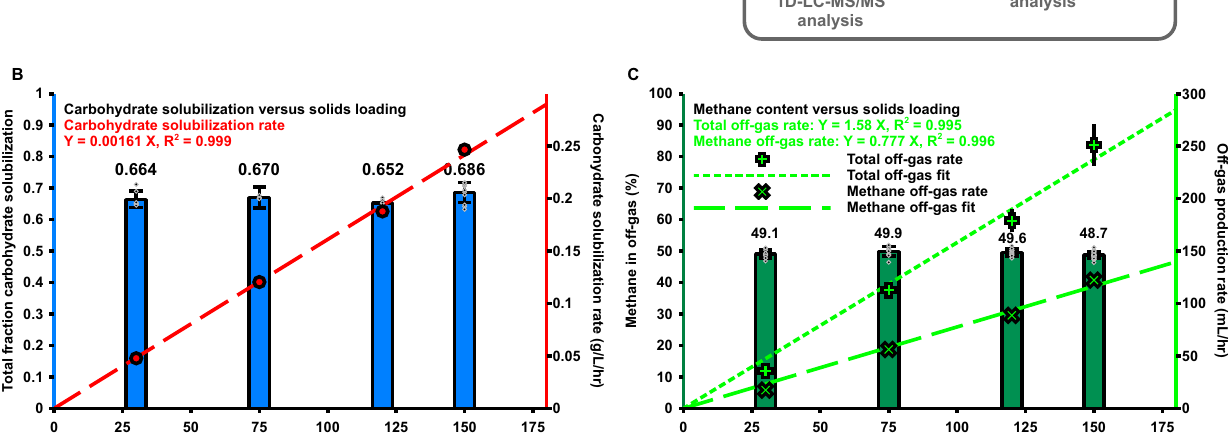
in substrate concentration; although signi fi cant abundance changes across a myriad of functional categories were observed with increasing solids (Fig. 1A, Supplementary Note 1, Supple- mentary Data 1). In order to further examine the changes in the community ’ s functional structure across solids loadings and deepen the overall analysis, a multidimensional metaproteomic measurement was conducted on fractionated microbiome sam- ples. As follows, each sample was split into three fractions: supernatant (SNT), planktonic cells (PC), and substrate-bound (SB). Sample fractionation to segregate extracellular proteins from planktonic- and substrate-bound microbes and enzymes has